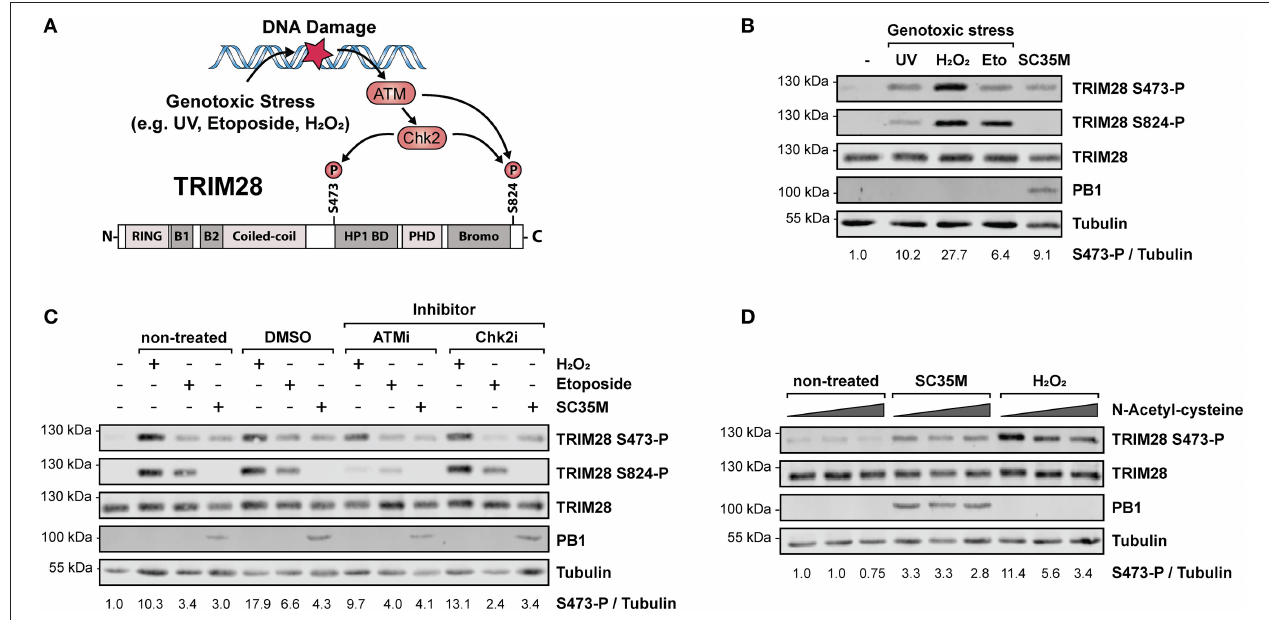
FIGURE 2 | Phosphorylation of TRIM28 S473 occurs by non-DDR related kinases during HPAIV infection. (A) Schematic representation of the involved kinases leading to TRIM28 S473 and S824 phosphorylation during DNA damage response. (B) A549 cells were treated with 250 µ M H 2 O 2 for 3h, 100 µ M etoposide for 6h, infected for 10h with SC35M at an MOI of 20 or treated with 1 kJ/m 2 ultraviolet light 30min prior to western blot analysis. TRIM28 phosphorylation was detected using antibodies specific for TRIM28 phosphorylated at S473 or S824, respectively. Total TRIM28 and tubulin served as loading controls. Infection was validated using an antibody targeting the viral protein PB1. (C) A549 cells were treated with inhibitors for ATM (KU-60019, 2.5 µ M), Chk2 (Chk2 Inhibitor II, 10 µ M) and the solvent control (DMSO, 10 µ M) 1h prior to stimulation with H 2 O 2 , etoposide and SC35M infection in the presence of the corresponding inhibitors. (D) A549 cells were treated with increasing amounts of the reactive oxygen species scavenger NAC (5, 10, 15mM) for 1h following stimulation with 500 µ M H 2 O 2 for 2h and infection with SC35M for 10h at an MOI of 20 in the presence of NAC. TRIM28 S473 phosphorylation was monitored by western blot.